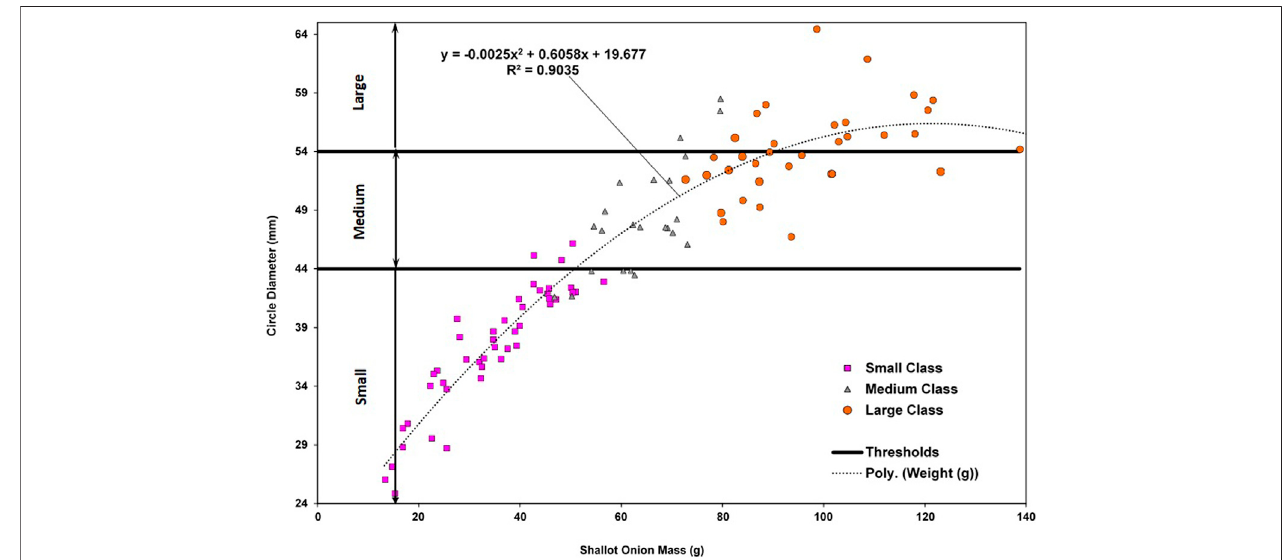
FIGURE 4 | Determination of size classes for classi fi cation.